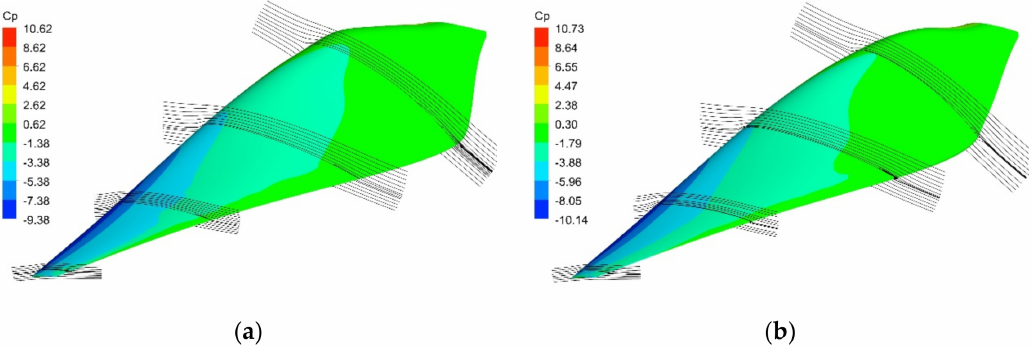
Figure 37. Pressure coefficient distribution and streamlines on different cross-sections of two pro- pellers at State 2: ( a ) Prop A; ( b ) Prop B.